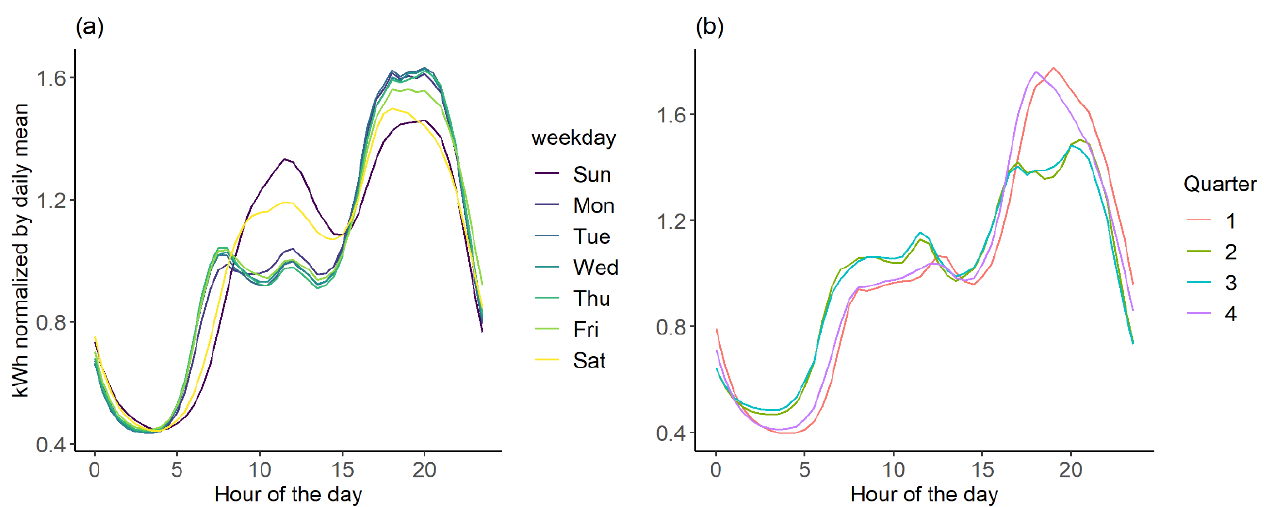
Figure 4. ( a ) Daily normalized energy use shape by day of the week. ( b ) Daily normalized energy use shape by quarter of the year.